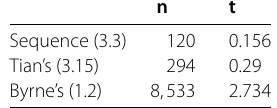
Table 2 (cid:2) = 10 –10 , P = 3, M = 3, N = 3